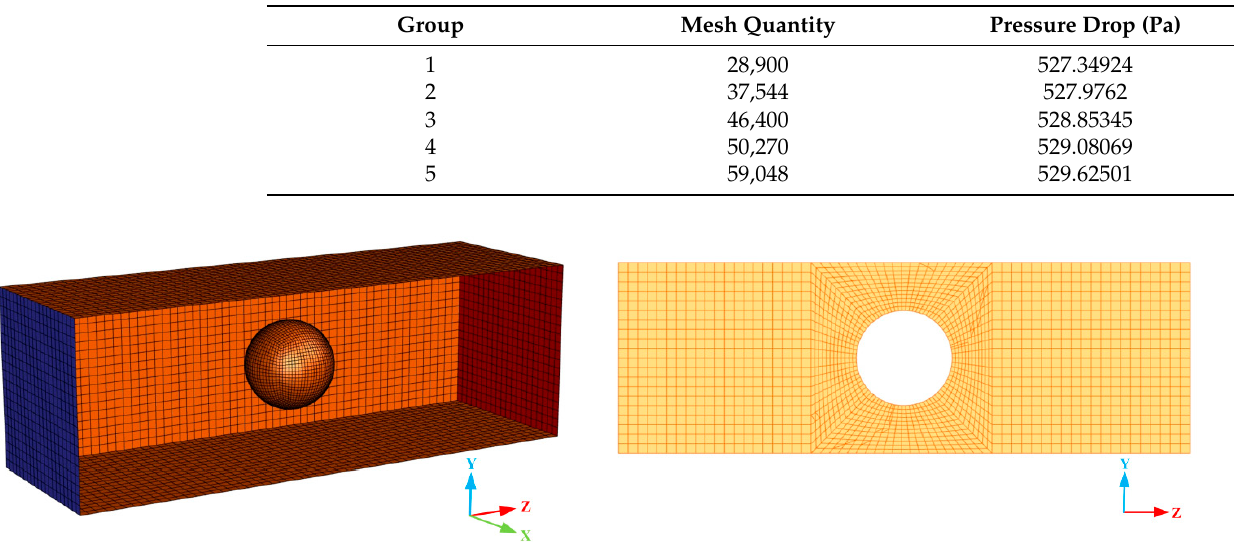
Figure 3. Mesh model of the fl uid